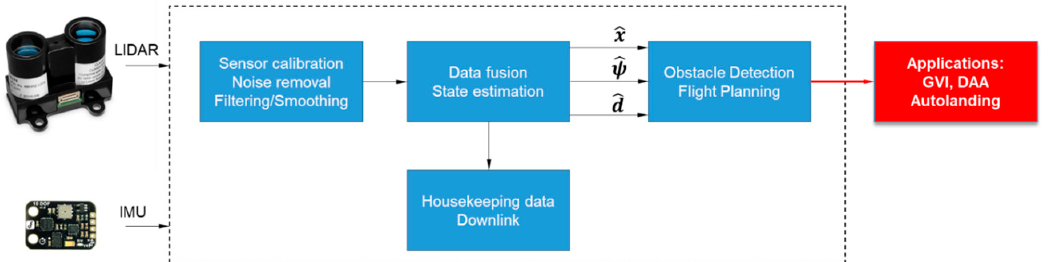
Figure 1. Conceptual block diagram of the Positioning, field mapping, Obstacle Detection and Avoiding (PODA) subsystem.